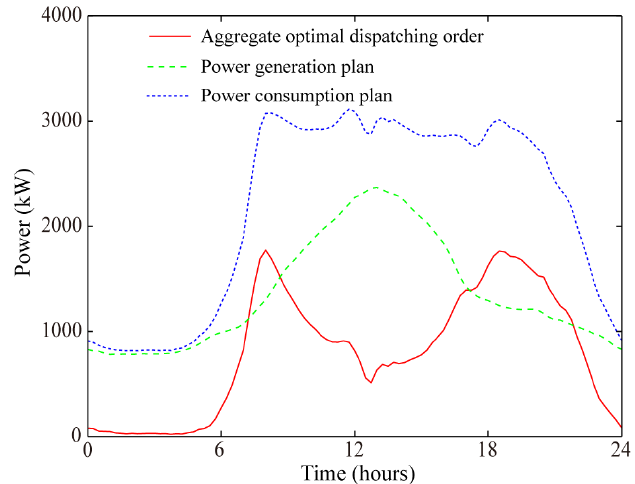
Figure 8. Optimal dispatching orders of the distribution network.